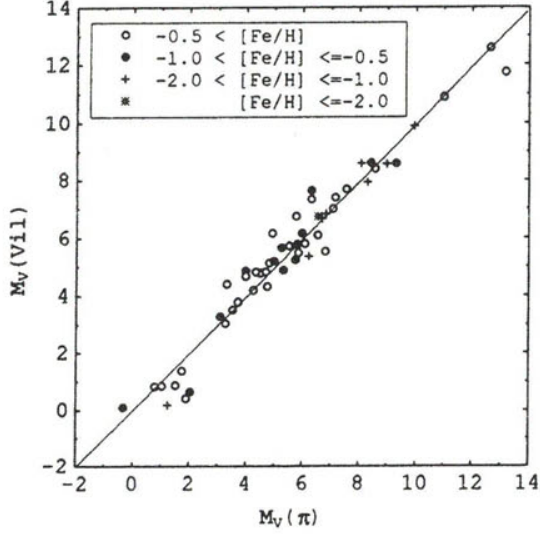
Fig. 7. Comparison of our absolute magnitudes with those from trigonometric parallaxes. The Lutz-Kelker corrections are applied to My (7r ).The solid line is a 45°